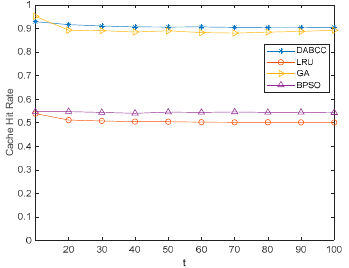
Figure 5. Cumulative cache hit